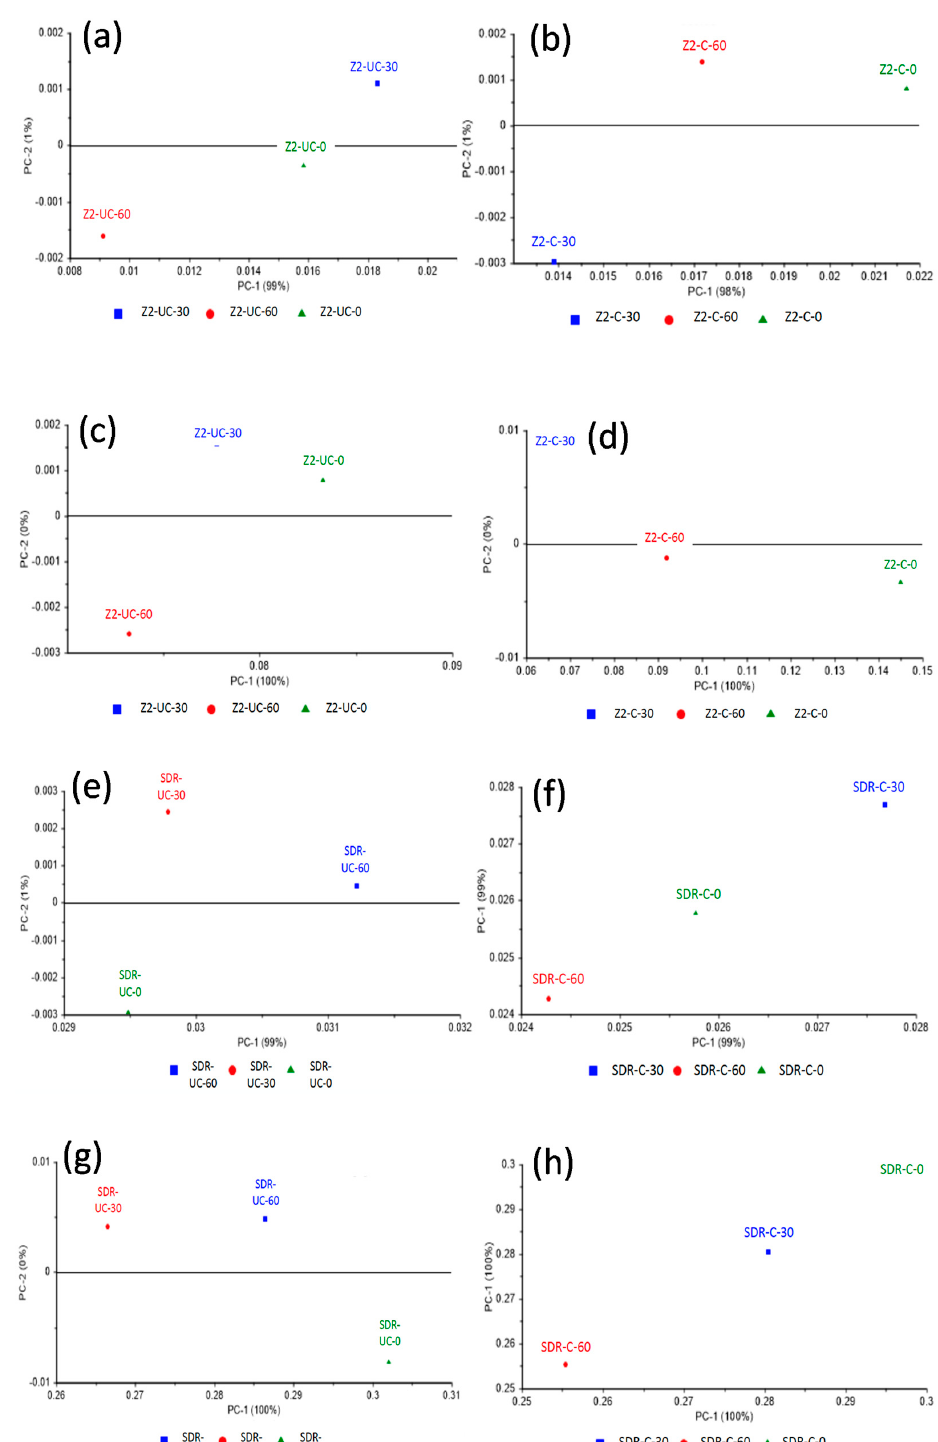
Figure 6. Principal component analysis of Filtek Z250 dental composite; ( a ) uncured and ( b ) cured at spectral range 1590–1650 cm − 1 , ( c ) uncured and ( d ) cured at spectral range 1700–1750 cm − 11 . Principal component analysis of SDR dental composite ( e ) uncured and ( f ) cured at spectral range 1590–1650 cm − 1 , ( g ) uncured and ( h ) cured at spectral range 1700–1750 cm − 1 . Both composites showed separation between control, 30 s, and 60 s of both cured and uncured phases at both the spectral ranges with 100% variance at 1700–1750 cm − 1 and 98% and 99% variances at 1590–1650 cm − 1 spectral range of cured and uncured SDR and Filtek Z250 dental composites,